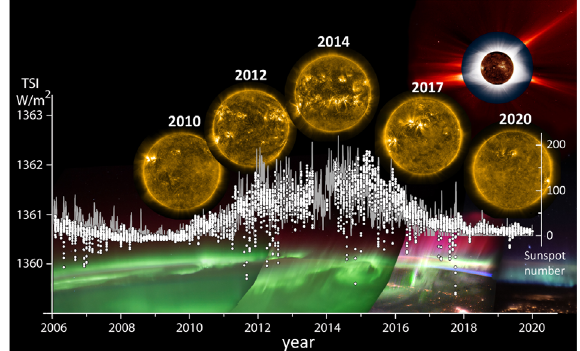
Fig. 1. Illustration of solar activity impacts on the Earth ’ s space environment during Solar Cycle 24. The solar activity increased the Total Solar Irradiance (TSI; white dots) during the solar maximum. Whole-disk observations of the solar corona in the extreme ultraviolet light (Fe IX, 171 Å) from the Atmospheric Imaging Assembly (AIA) instrument onboard NASA ’ s Solar Dynamics Observatory (SDO) show numerous brightenings caused by magnetic active regions emerging from the solar interior. Aurora images at the bottom are taken from the International Space Station at different solar cycle stages. The upper right corner shows a composite image of the Sun during the total solar eclipse of 2017, at the maximum of solar activity. It includes observations from the NASA instruments LASCO (SOHO mission, in red color), AIA (SDO mission, in brown color), and ground observations of the inner corona by Jay M.